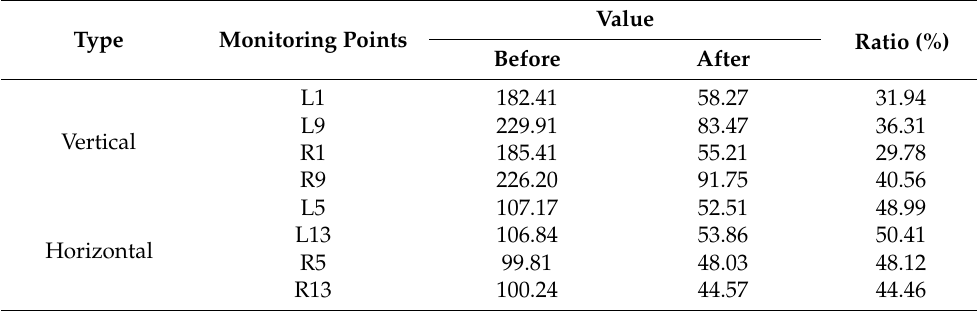
Table 2. Variations of earth pressure around tunnel before and after excavation (unit: kPa).